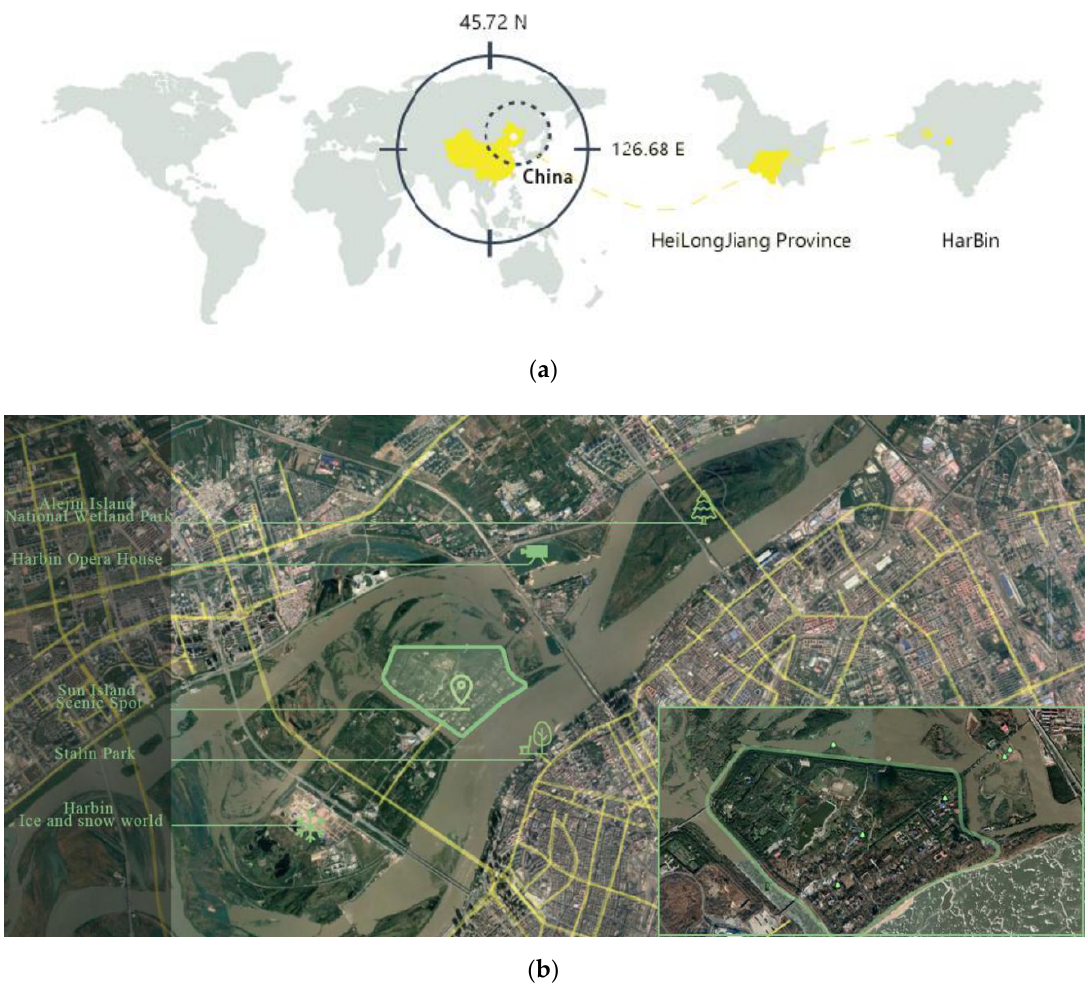
Figure 1. Site location analysis: ( a ) location analysis of Harbin; ( b ) geographical location of the experimental site.